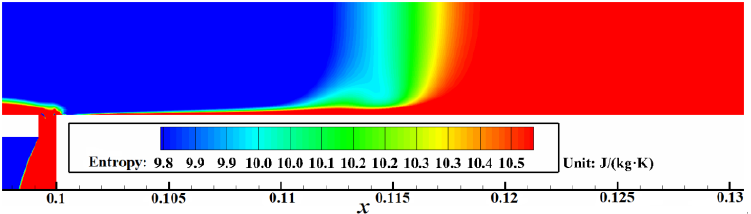
Figure 16. Entropy distribution at 0.30 ms for the case of gap width of 0.8 mm, pressure ratio of 1.5.